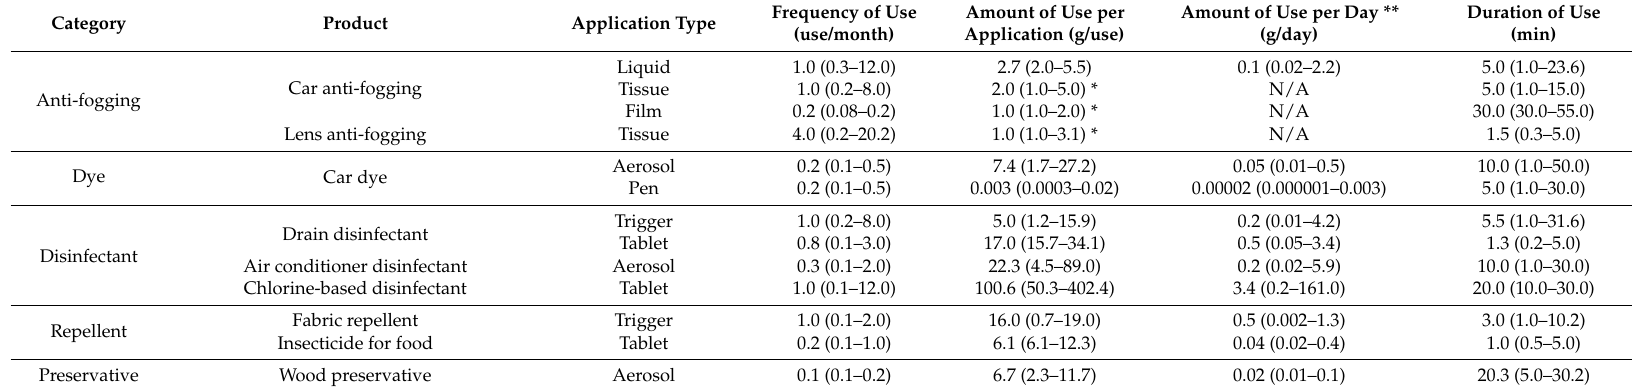
Table 3. Summarized statistics (median and interquartile range * ) of exposure factors by product and application type.